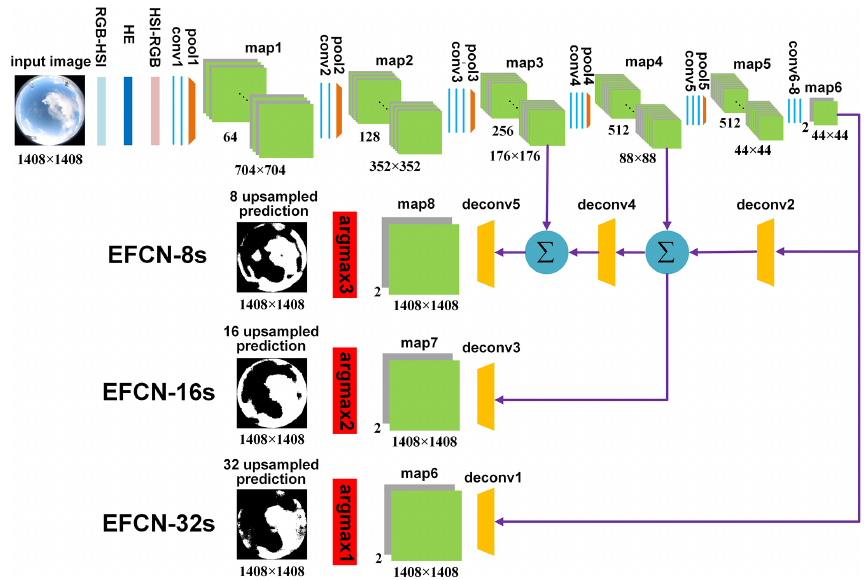
Figure 4. Detailed architecture of EFCN model including RGB–HSI layer, histogram equalization layer, HSI–RGB layer, convolutional layers, pooling layers, deconvolutional layers, skip connection, and activation